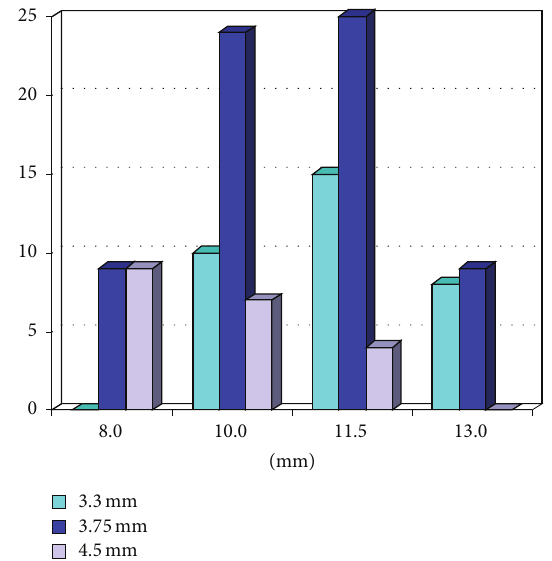
Figure 4: Distribution of the implants by length and